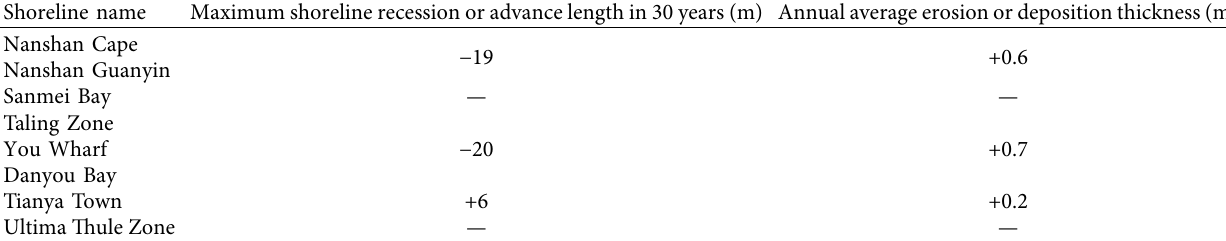
Table 2: Shoreline evolution before SSRA.